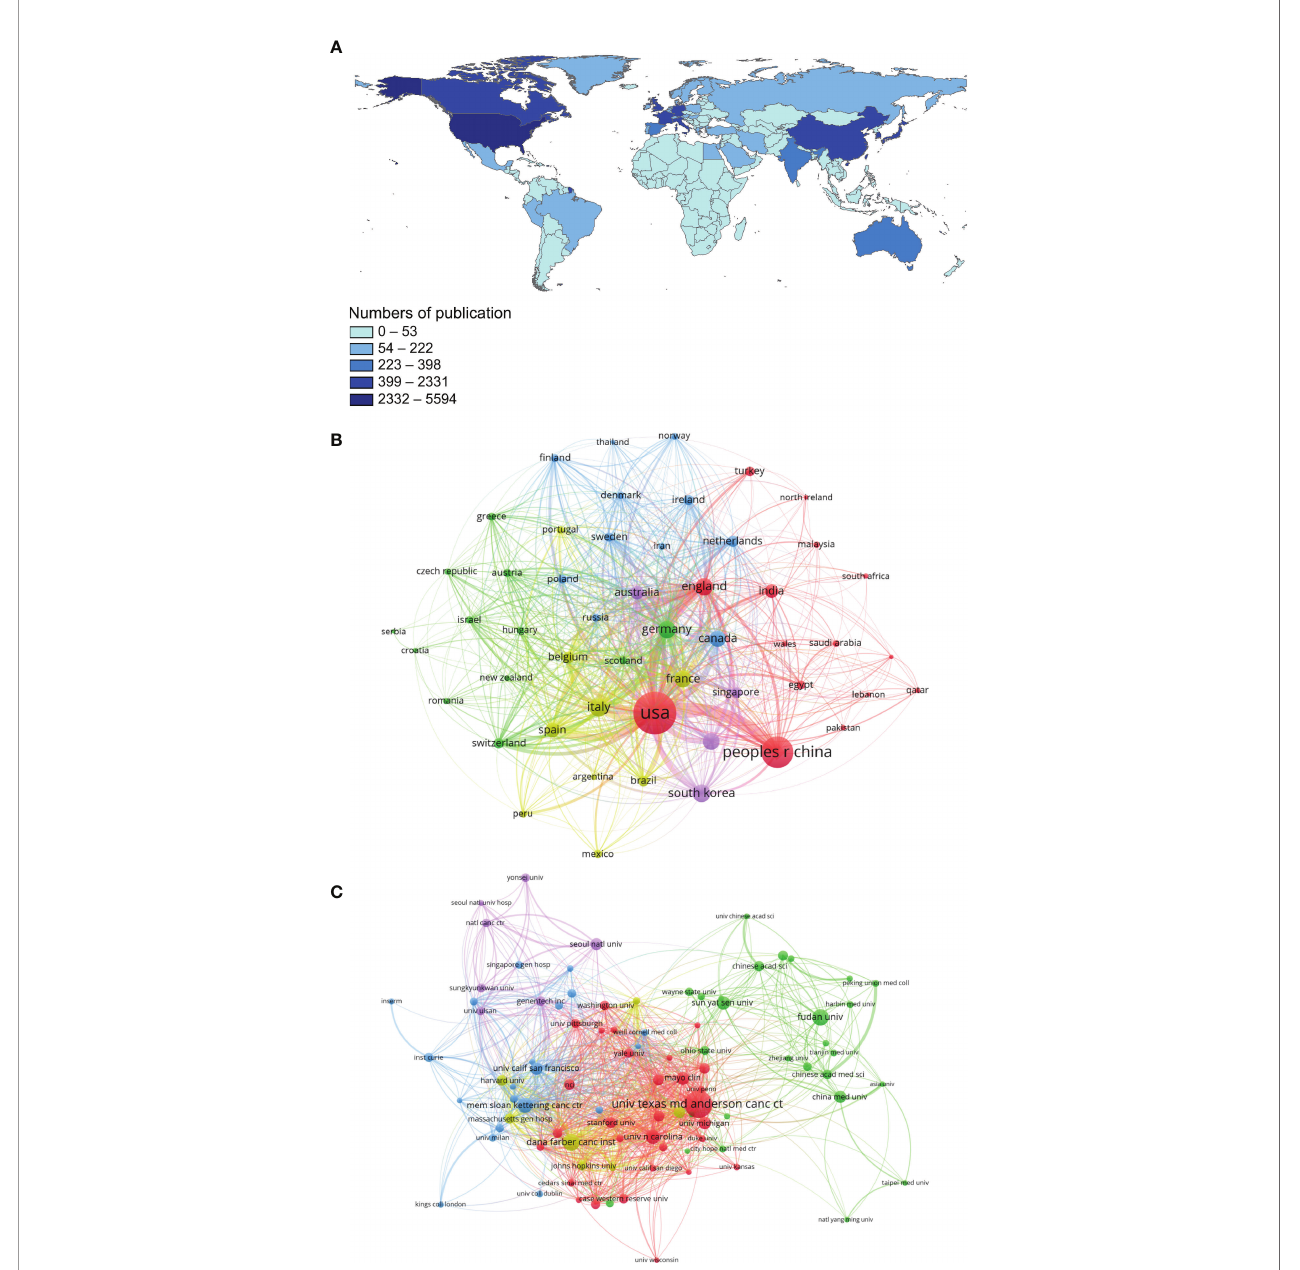
FIGURE 2 | Main countries/regions and institutions of TNBC research and their interrelationships. (A) Countries/Regions distribution of TNBC-related research results; (B) A visualization network of collaboration between countries/regions in TNBC research; (C) A visualization network of collaboration among institutions in TNBC